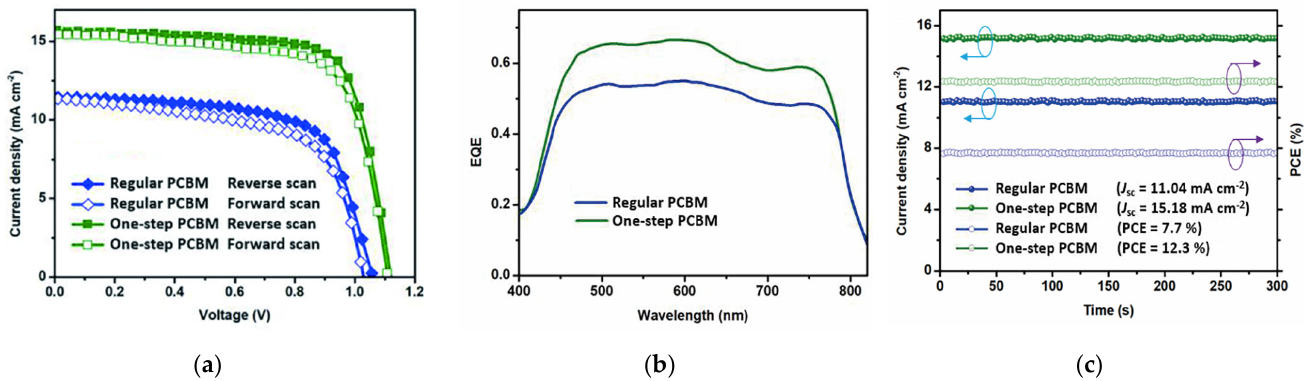
Figure 2. ( a ) J-V characteristics (reverse and forward scan), ( b ) EQE spectra, and ( c ) stabilized photocurrent as well as PCE outputs of 2D PSCs with PCBM formed with regular and one-step method.